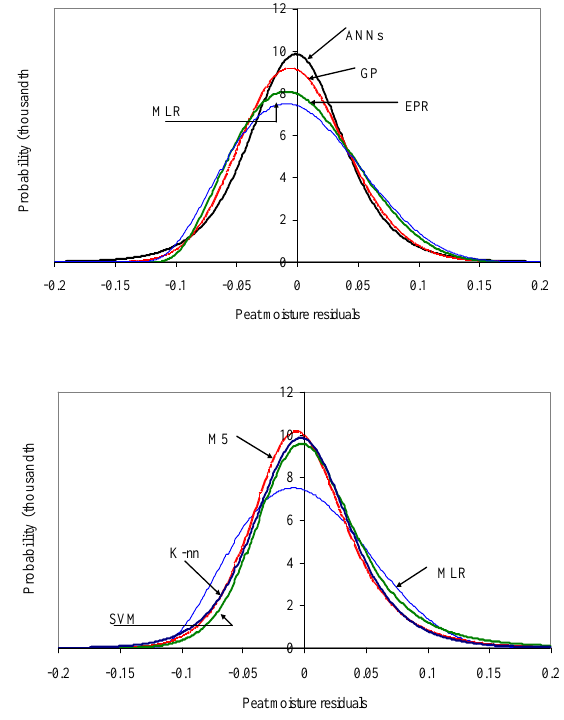
Fig. 8. Probability distribution of the 12 model residuals of all tech- niques (peat moisture case study).